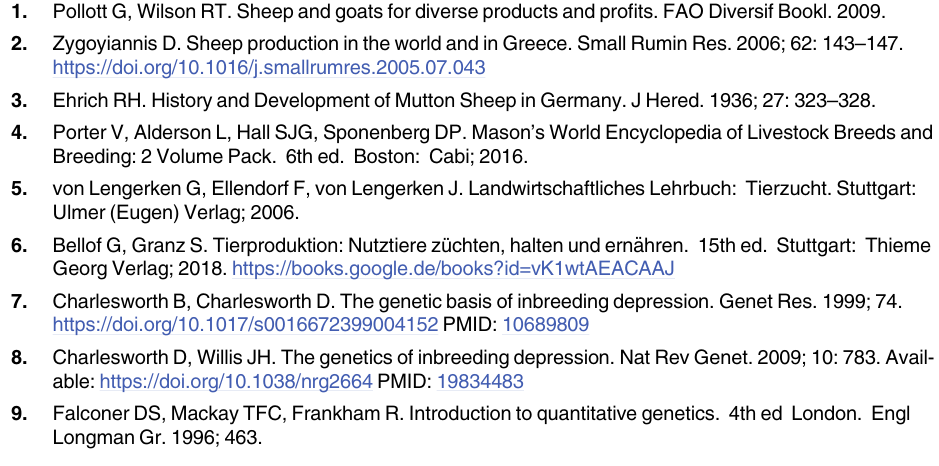
S2 Table. Ranking of chromosomes based on their mean inbreeding estimates calculated relative to either entire autosome (F Right). Cumulative inbreeding values and percentages are provided for F